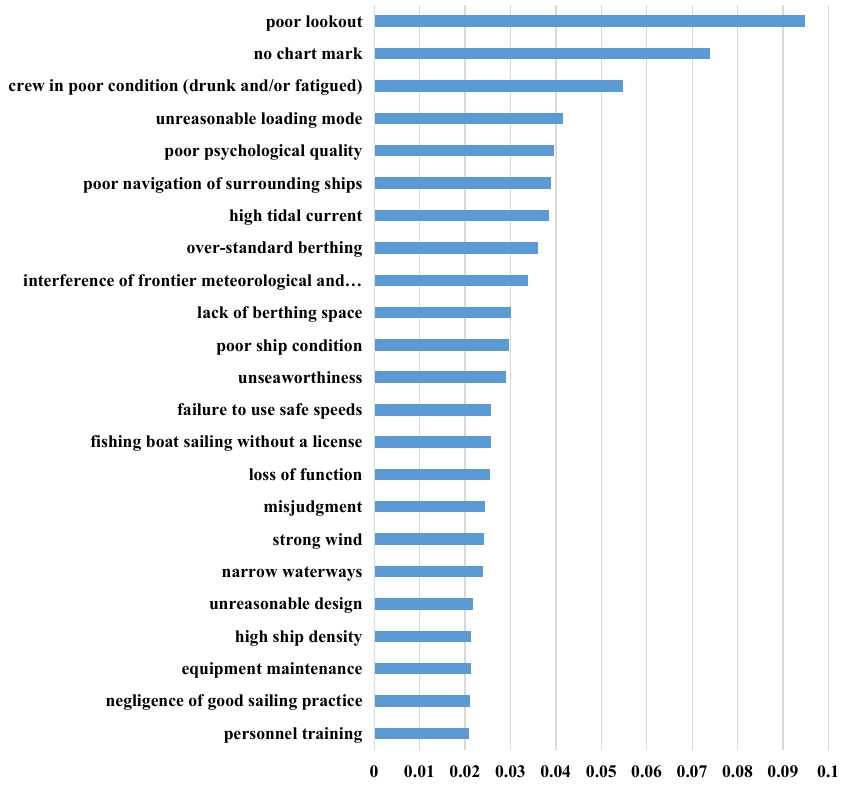
Figure 8. Feature importance